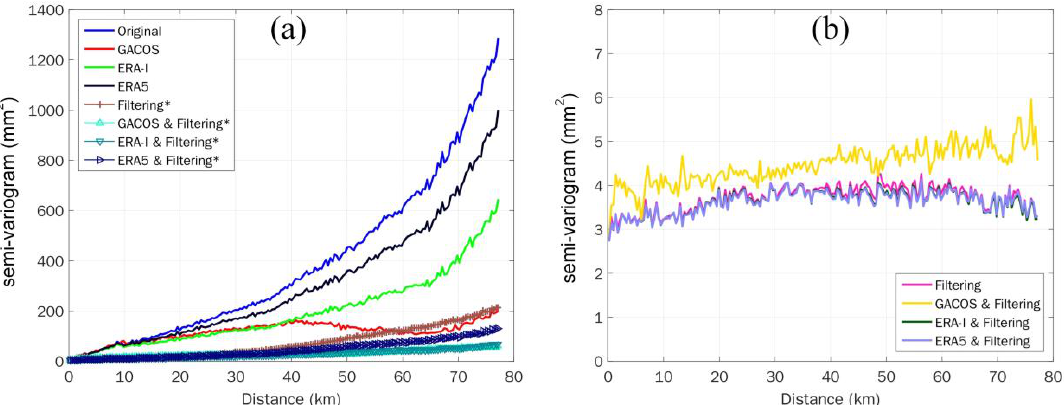
Figure 9. Semi-variograms of the 20170312–20170815 interferogram before and after tropospheric corrections. ( a ) No correction, GACOS, ERA-I, ERA5 correction, or combined approaches with the primary TOE retained. ( b ) Corrections using spatiotemporal filtering or the combined approaches, after removing the primary TOE. The symbol “*” denote the corrections with primary TOE retained in the interferograms.